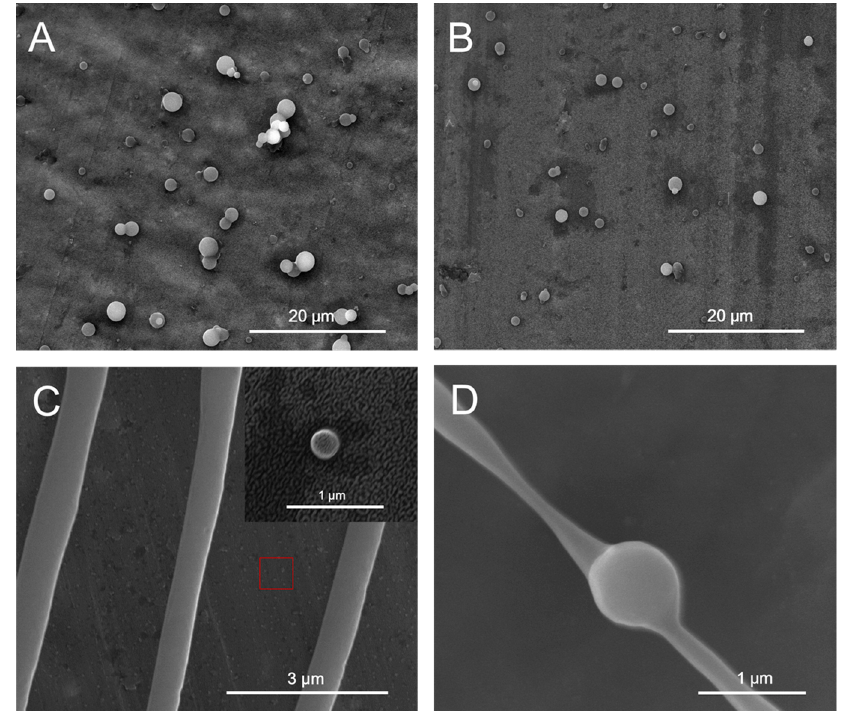
Figure 3. SEM images of mPEG 43 -PMCC 25 -P(MCC-DHO) 15 self-assembly obtained in water at ( A ) pH = 4.0, ( B ) pH = 6.0, ( C ) pH = 7.0 and ( D ) pH = 8.0. The inset at higher right in ( C ) is an enlargement of the spherical aggregates in the selected rectangular area.